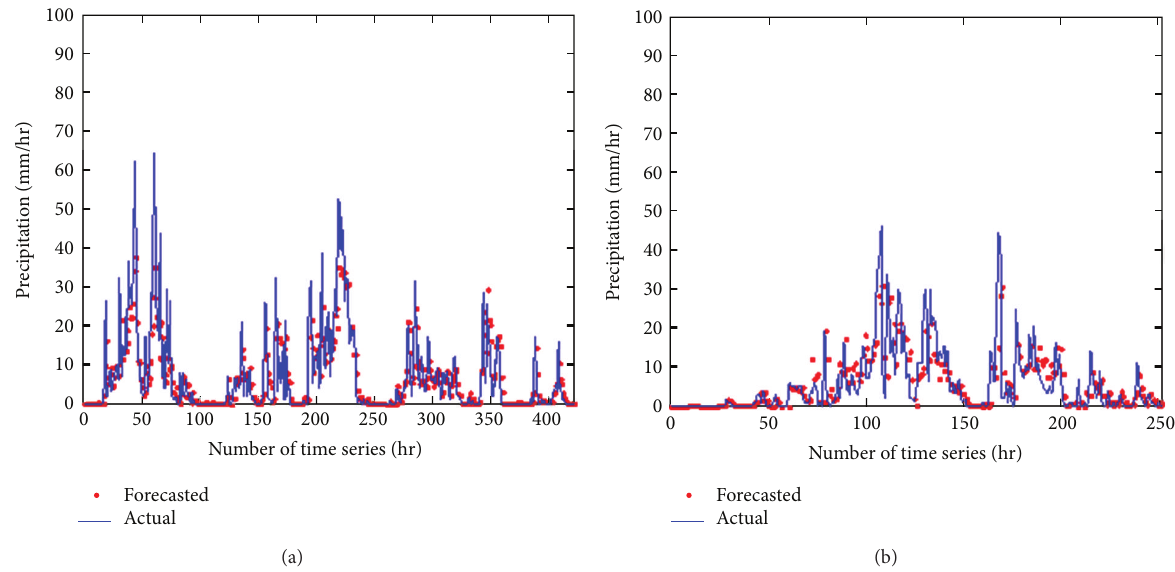
Figure 17: The validation and testing precipitation forecast results at 𝑡 + 1 of the ANFIS-based hybrid dual-model at Hsia-Yun station: (a) validation; (b)